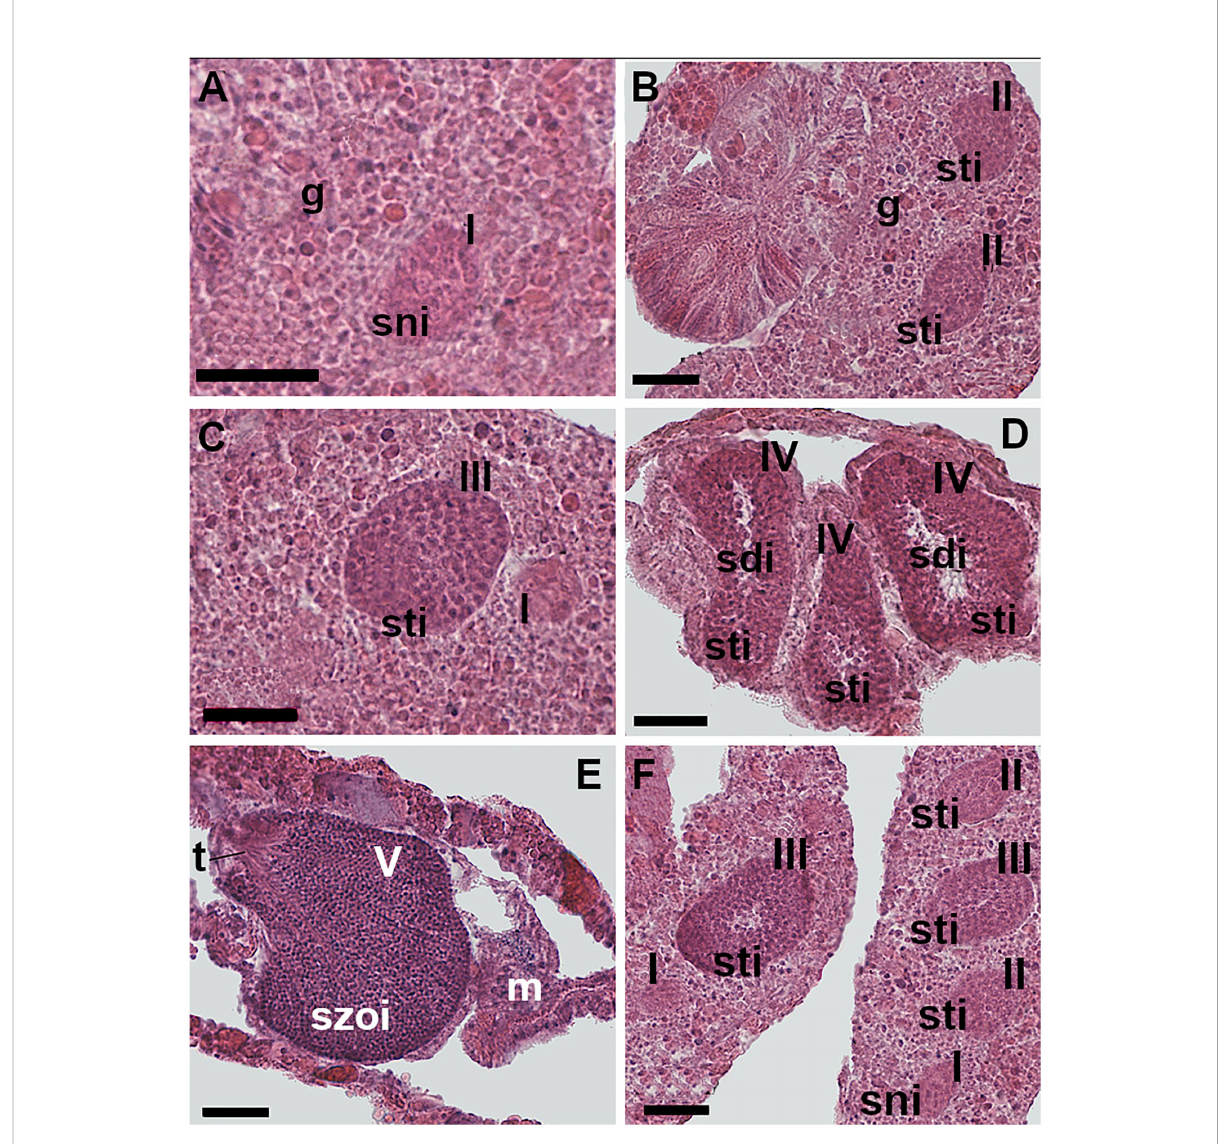
FIGURE 4 Spermatogenesis. (A) Stage I: undifferentiated germ cells disposed in the gastrodermis layers of the mesentery. The spermaries are made up of a group of spermatogonia. (B) Stage II: the spermaries are made up by spermatocytes involved in the process of meiosis. (C) Stage III: the spermary, containing spermatocytes undergoing meiosis, is delineated by a wall that has arisen from the mesoglea. (D) Stage IV: the spermary presents an external layer of spermatocytes and an internal mass of spermatids, recognizable by the presence of a tail. (E) Stage V: the spermary is made up of a mass of spermatozoa. Shortly before leaving the spermary, mature spermatozoa form a bouquet, with their tails all facing in the same direction. (F) Spermaries of stages I, II, and III located in the same mesentery. [g: gastrodermis; m: mesoglea; sni: spermatogonia; sti: spermatocytes; sdi: spermatids; szoi: spermatozoa; t: spermatozoa tails; I, II, III, IV, V: spermary developmental stage]. Scale bars are 25 m